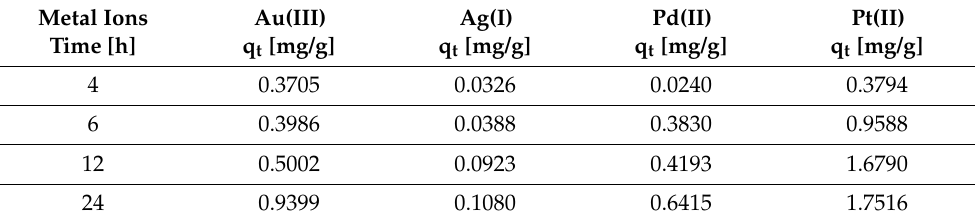
Table 2. The changes in sorption capacity of the membranes with 20 wt.% 2,6-bis(4-methoxybenzoyl)- diaminopyridine over time during sorption